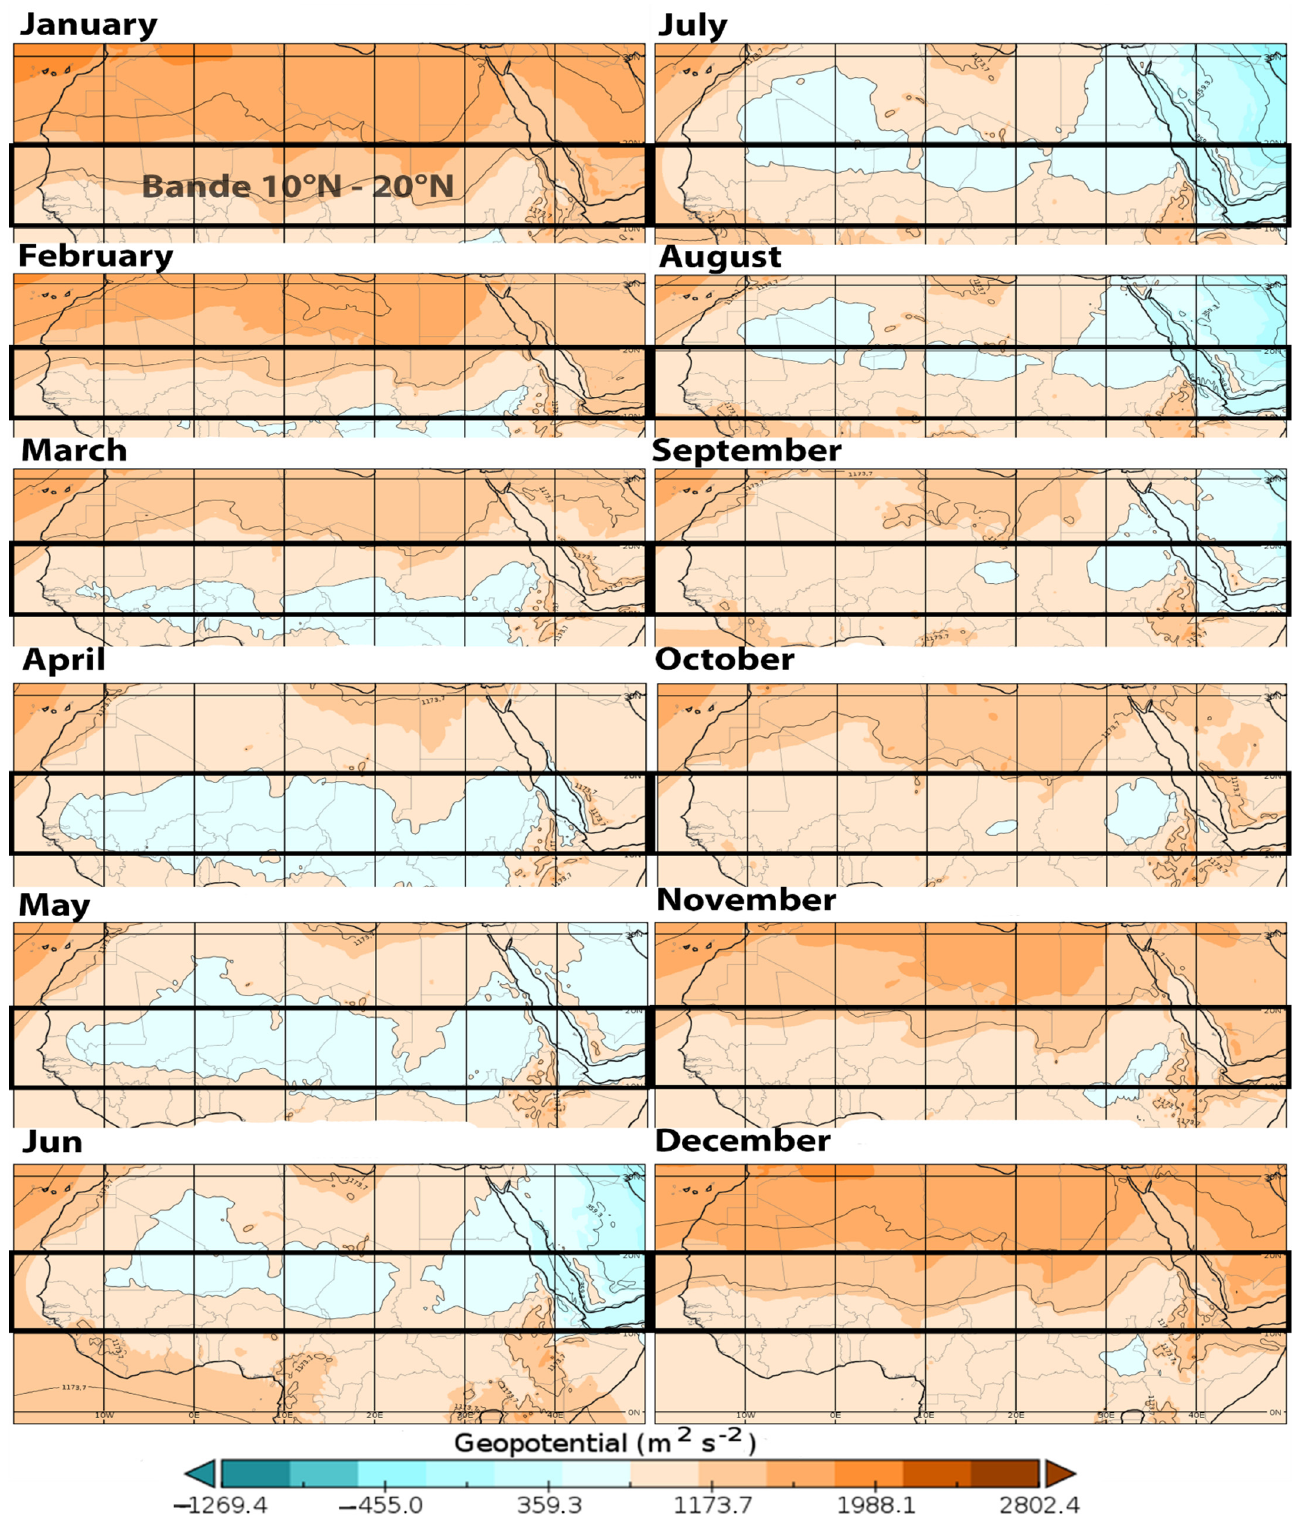
Figure 10. Monthly average climatology of the Geopotential (4D-Var ERA5) in m 2 s − 2 from 1979 to 2008 with a resolution of 0.5 × 0.5 degrees. Data from the ERA5 platform.